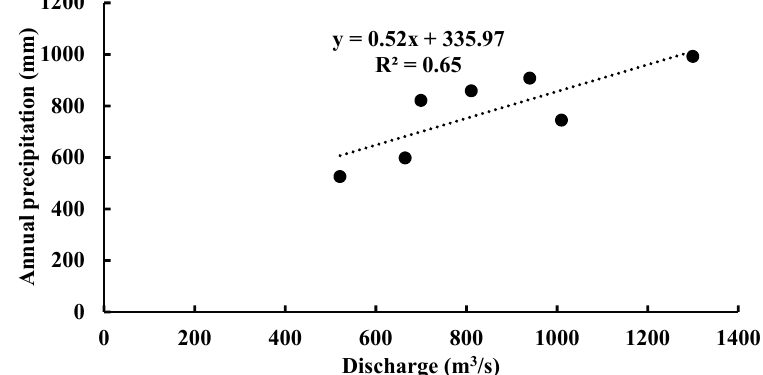
Figure 10. Regression analysis between discharge at Huangzhuang hydrologic station and annual precipitation at Laohekou meteorological station.